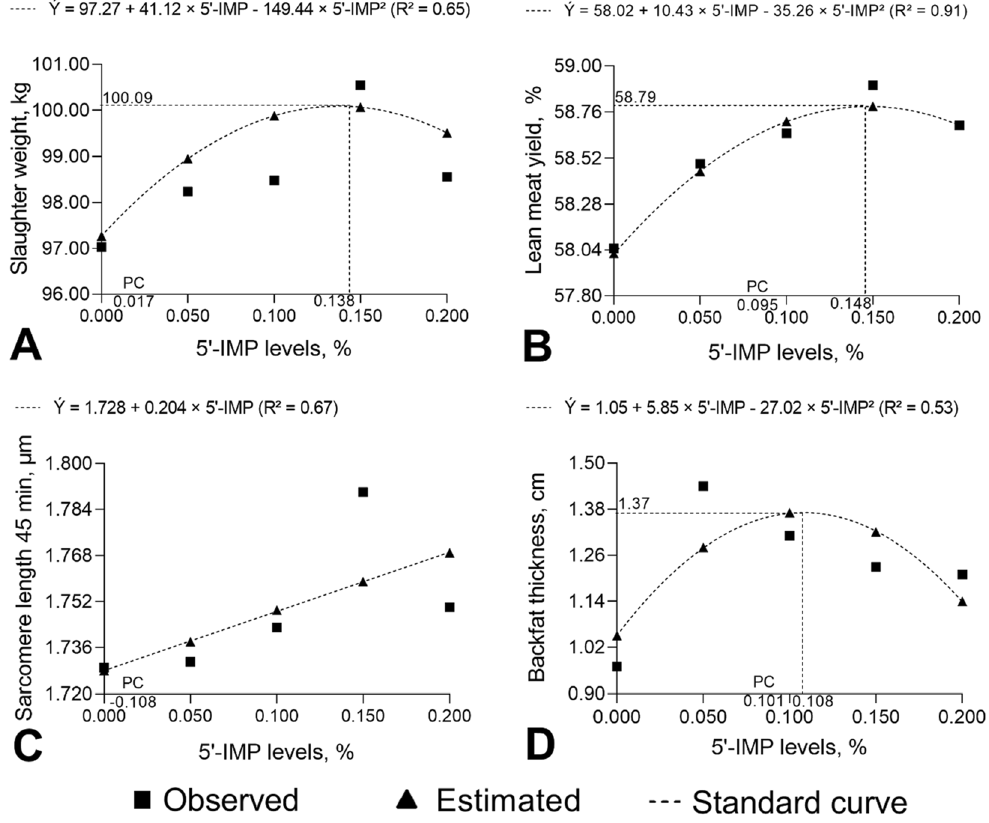
Figure 5. Slaughter weight ( A ), lean meat yield ( B ), sarcomere length 45 min after slaughter ( C ) and backfat thickness ( D ) of 75–100 kg barrows fed diets containing different levels of inosine-5 ′ -monophosphate (5 ′ -IMP) and a 100 kcal/kg lower metabolizable energy level than the positive control (high-energy)